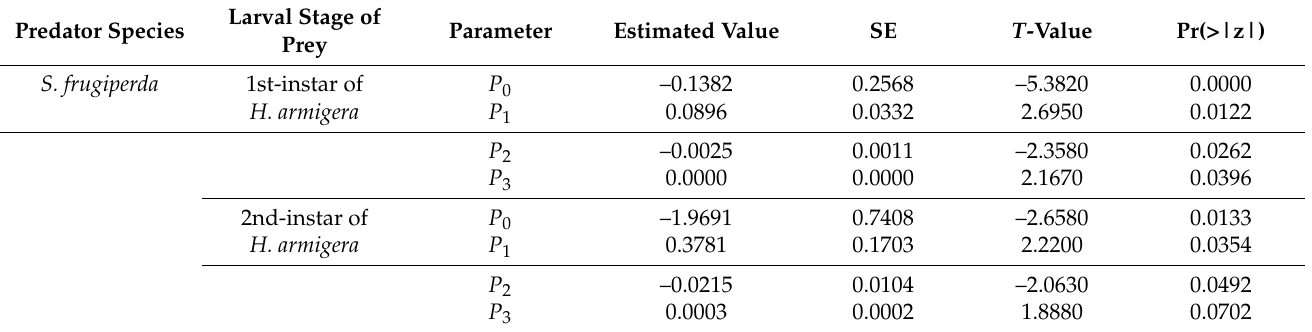
Figure 2. Functional response curves of sixth-instar predator larvae of Spodoptera frugiperda (FAW) or Helicoverpa armigera (CBW) preying on fi rst- ( a ), second ( b ) larvae of each other.